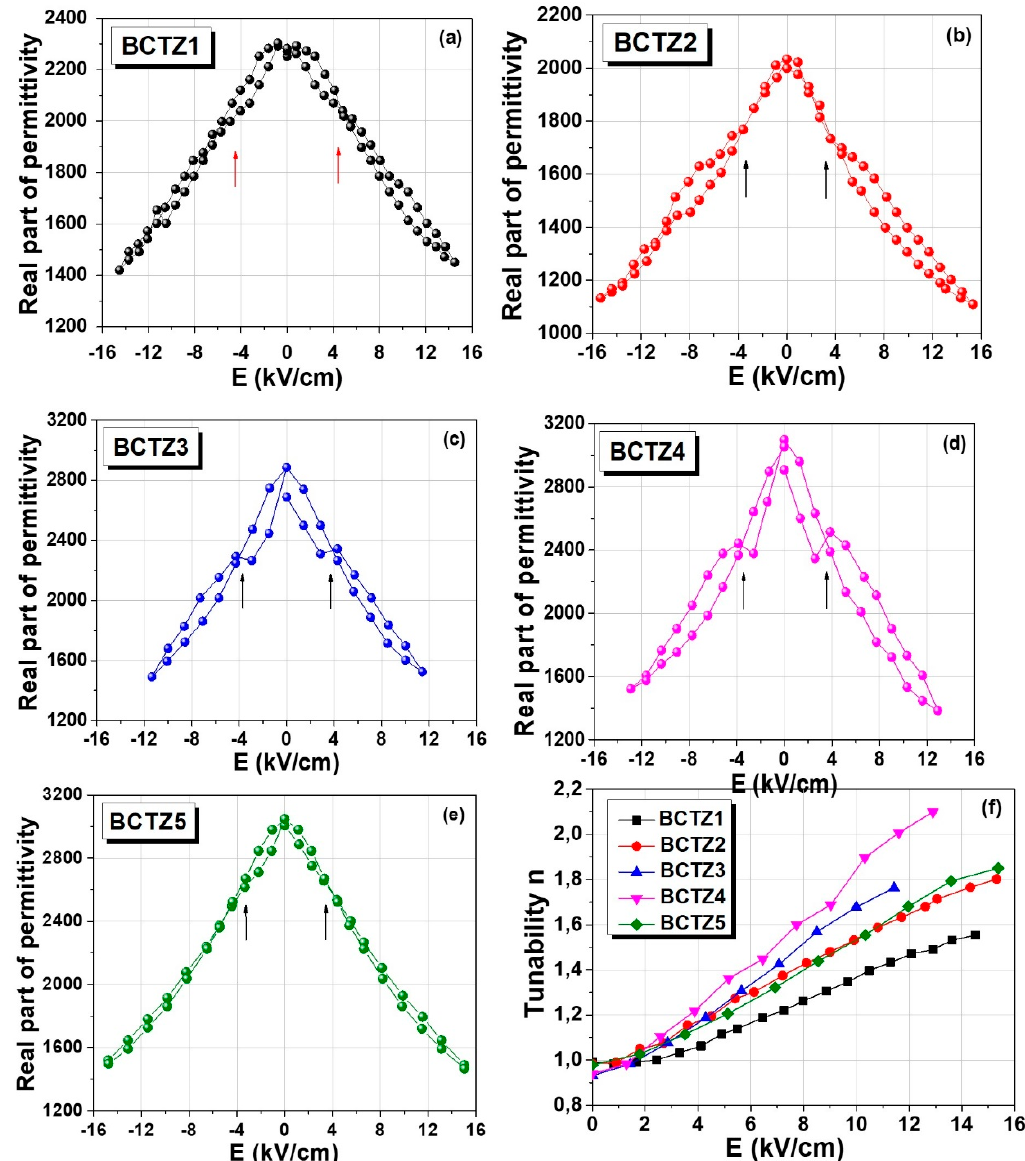
Figure 6. Permittivity vs. dc-electric field under an increased/decreased field cycle ( a – e ) and comparative tunability dependence on the dc-electric field ( f ) for all of the BCTZ ceramics.